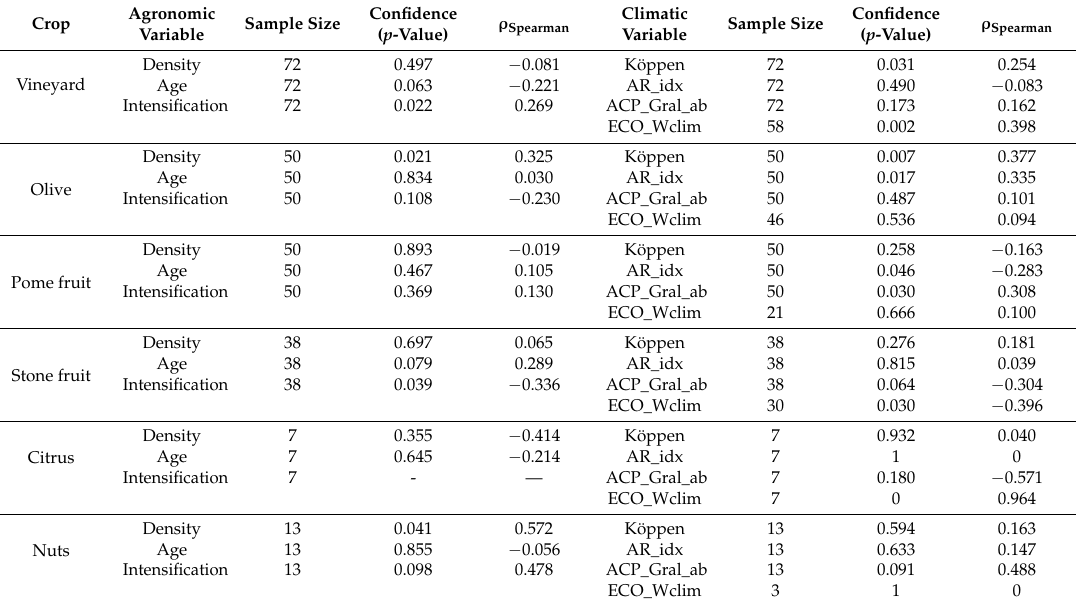
Table 3. Result of the correlation analysis between RSR (t · ha − 1 d.m.) and the agronomic- and climatic-like